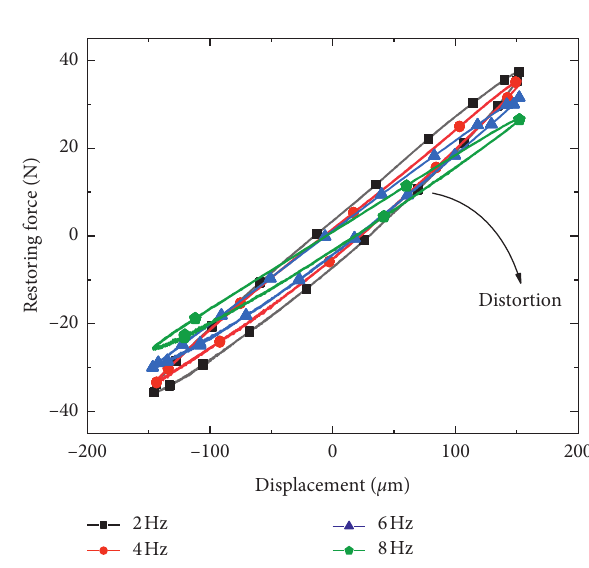
Figure 6: The distortion of hysteresis loops with respect to the change of frequency (( A ) � 150 μ